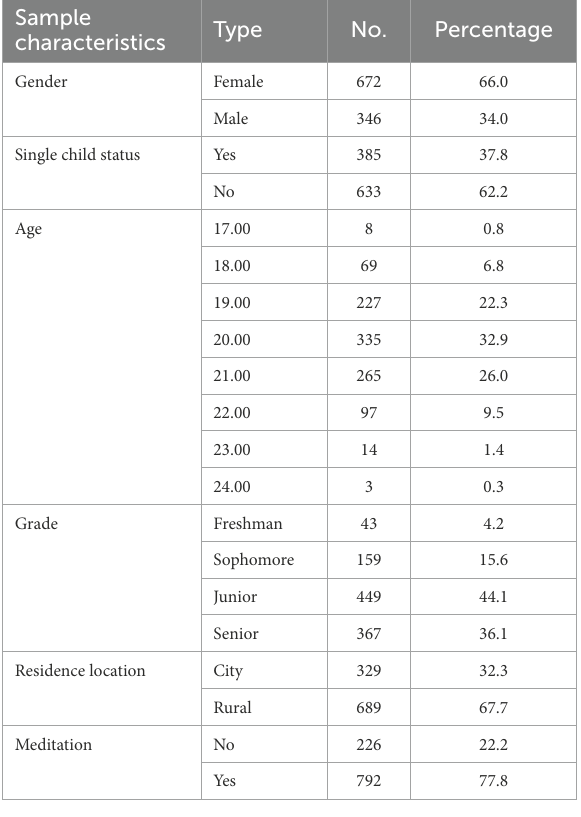
Table 3 testing the mediation role of